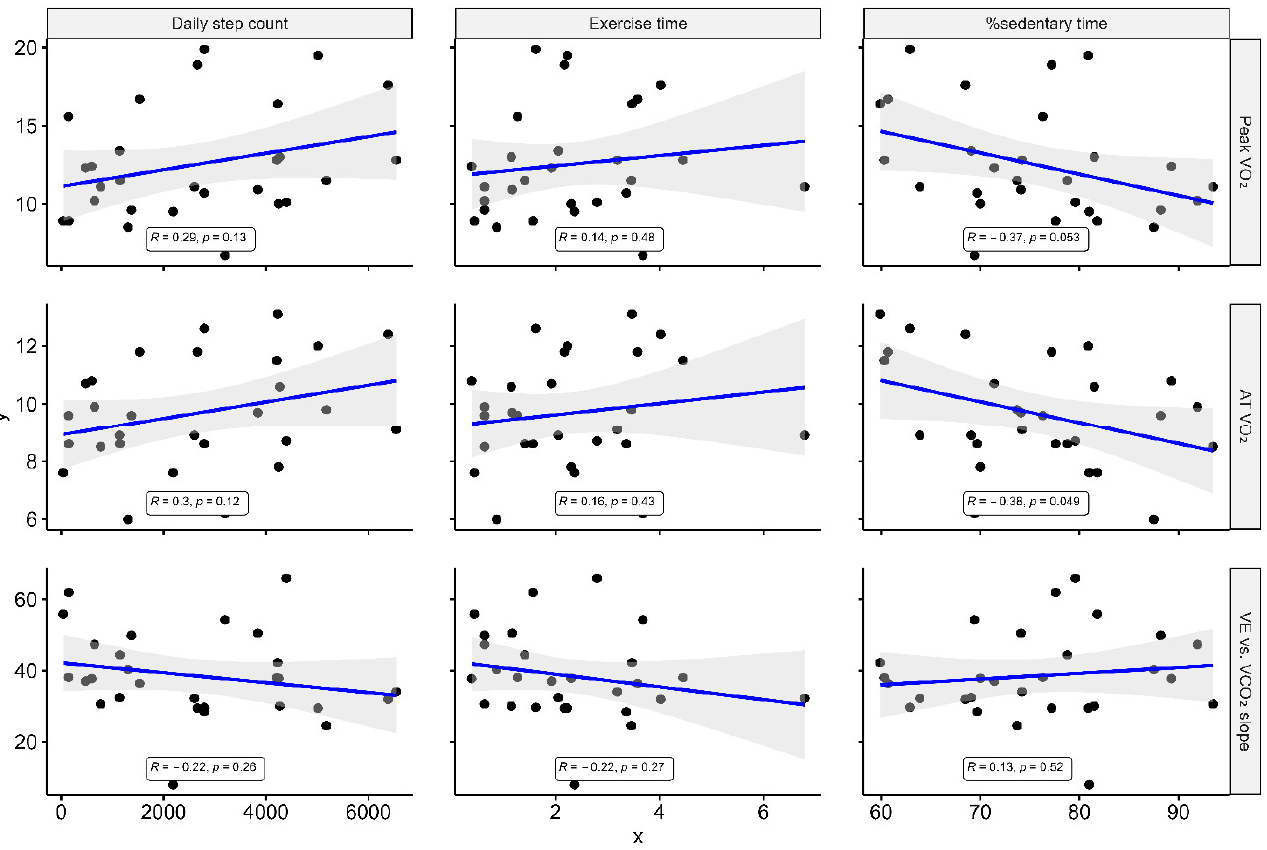
Figure 4. Correlation of accelerometer-measured physical activity with CPX parameters. R represents Pearson’s correlation coefficient. VO 2 = oxygen consumption; VCO 2 = carbon dioxide production; VE = expiratory minute volume; AT = anaerobic threshold.